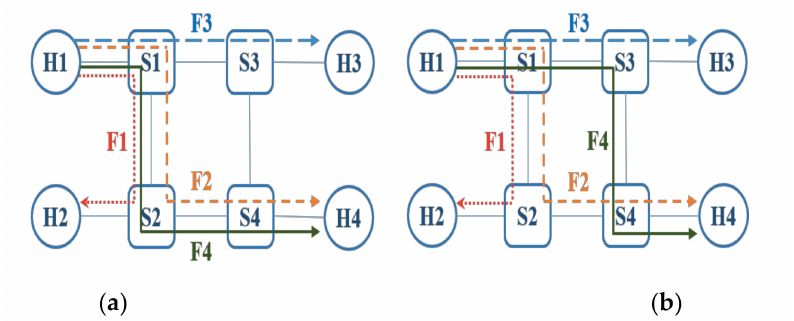
Figure 3. The practical experiment of the example of two di ff erent routing schemes shown in ( a ) and ( b )